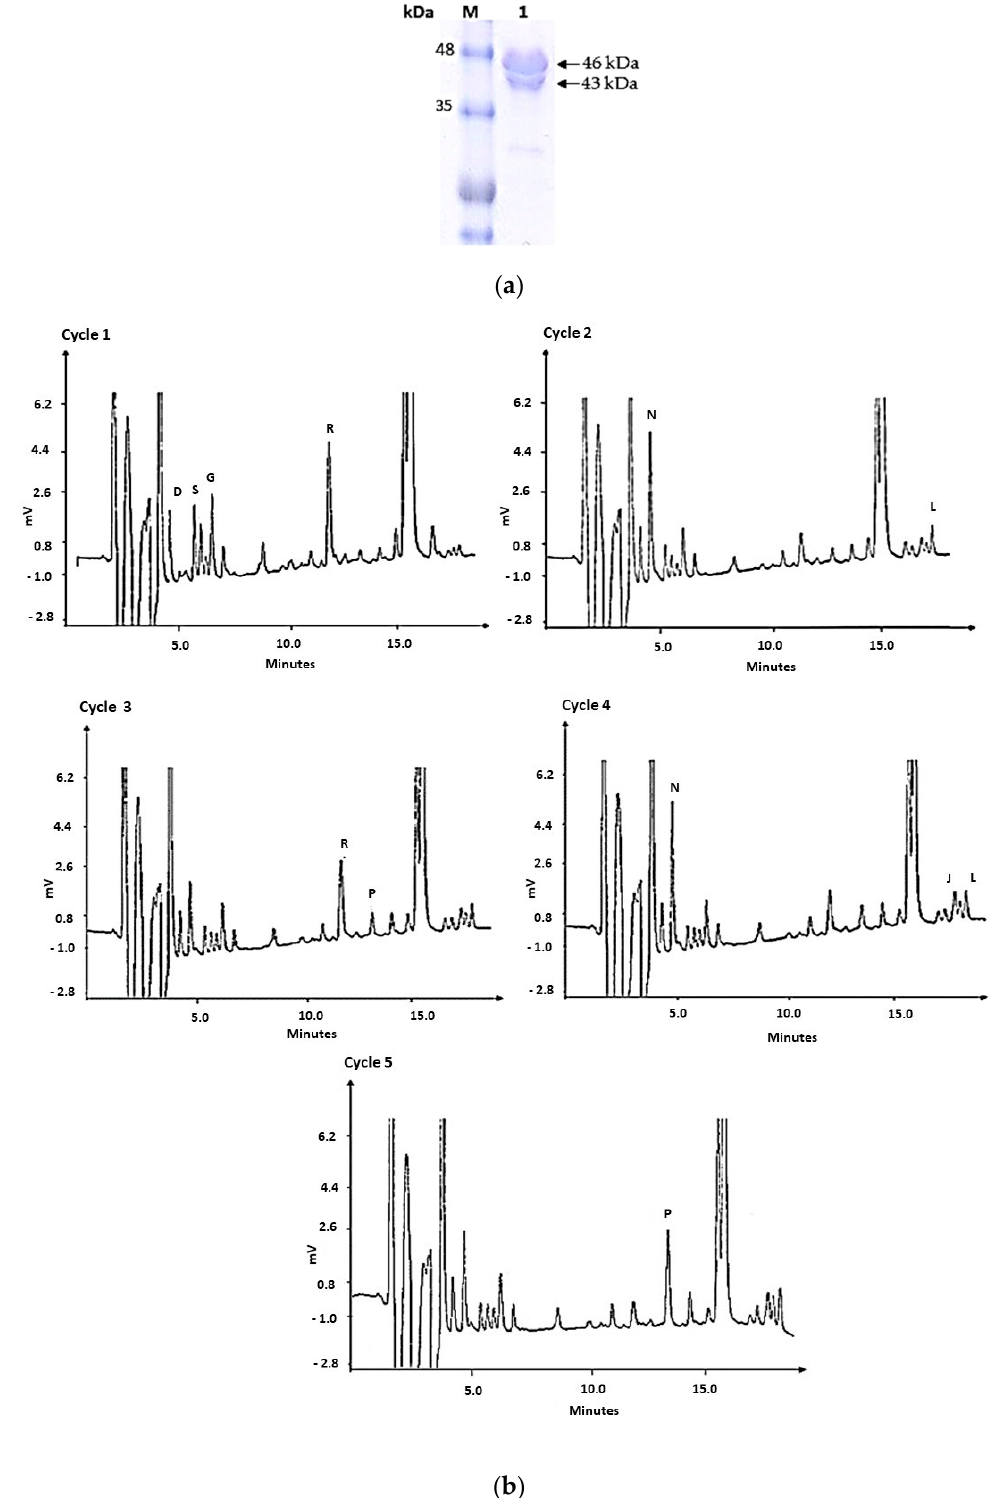
Figure 1. Identification of proteolytic cleavage site of MrNV CP using the Edman degradation sequencing. ( a ) MrNV CP on a SDS-polyacrylamide gel (12% w / v ) stained with Coomassie Brilliant Blue (CBB). The degraded band (43 kDa) was subjected to the Edman degradation (N-terminal) amino acid sequencing. ( b ) Sequencing analysis revealed an unambiguous main chain sequence from cycles 1–5 was